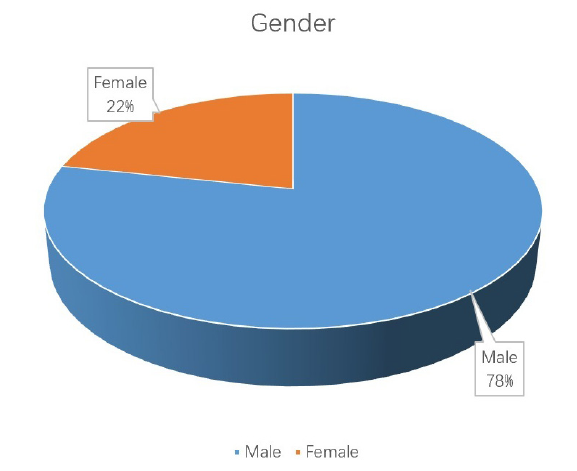
Fig. 2. Gender of the